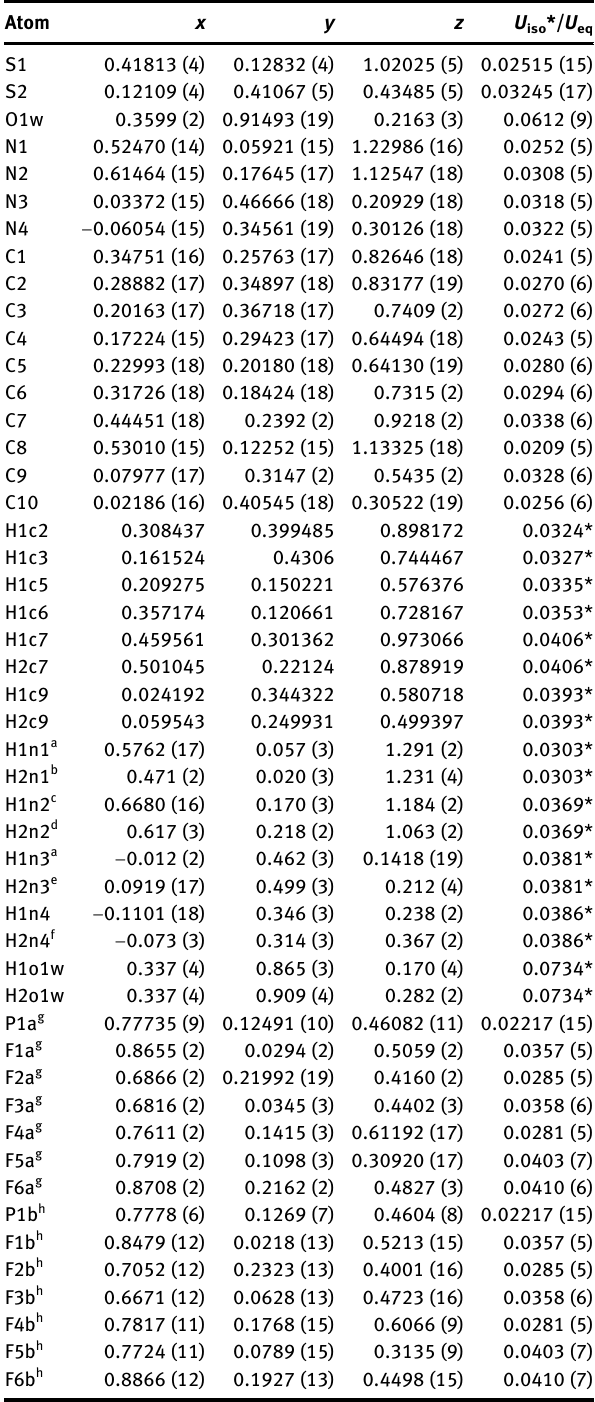
Table  : Fractional atomic coordinates and isotropic or equivalent isotropic displacement parameters (Å 